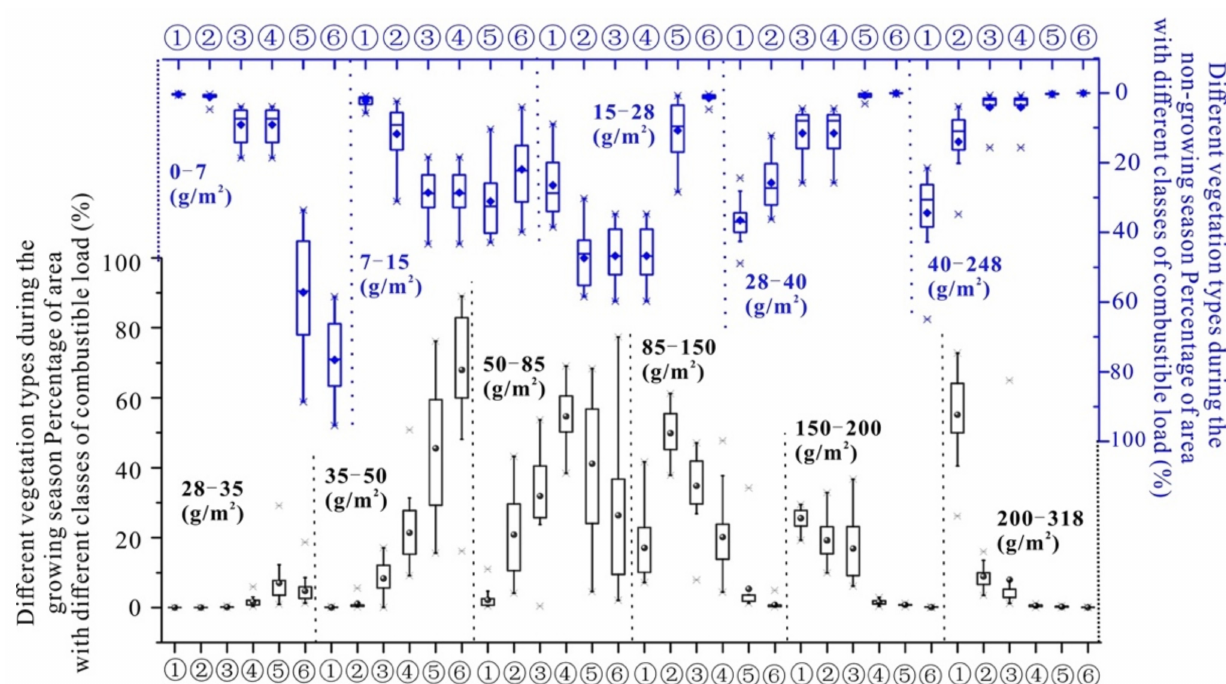
Figure 4. Percentage of combustible load classes for different vegetation types from 2001 to 2016 (Note: 1 (cid:13) – 6 (cid:13) see Figure